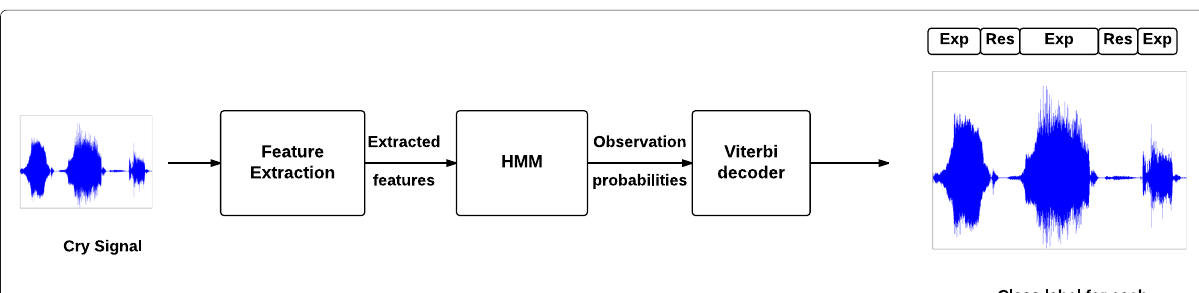
Fig. 2 Block diagram of the audio segmentation